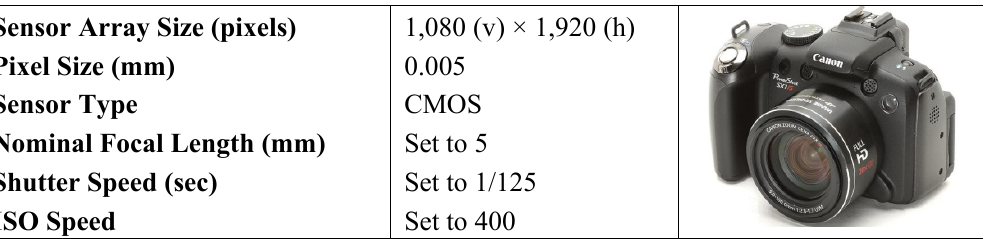
Table 2. Canon Power Shot SX1 IS camera specifications.